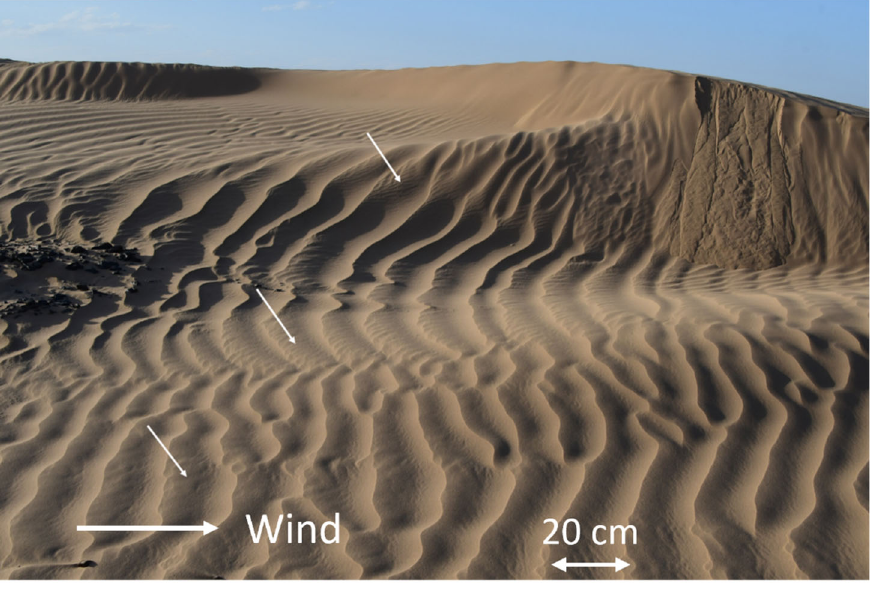
Figure 11. Multiscale impact ripples in fine sand at a lee slope of a small dune near Merzuga Morocco. The white arrows indicate secondary ripples developed by winds perpendicular and oblique to the large ripples. In some places, small ripples have developed parallel to the dominant direction of the large ripples.